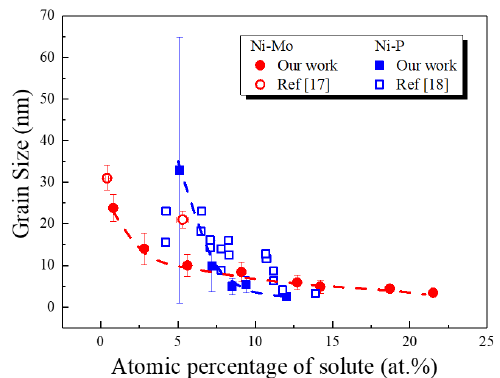
Figure 5. Grain size dependence of ng Ni-Mo alloys and Ni-P alloys on the atomic percentage of the solute atom (Mo and P), with the red line standing for Ni-Mo and the blue one representing Ni-P, respectively. The red circles stand for data of Ni-Mo, with blue squares representing those of Ni-P; the solid symbols are our results, with hollow ones being from references [17,18].